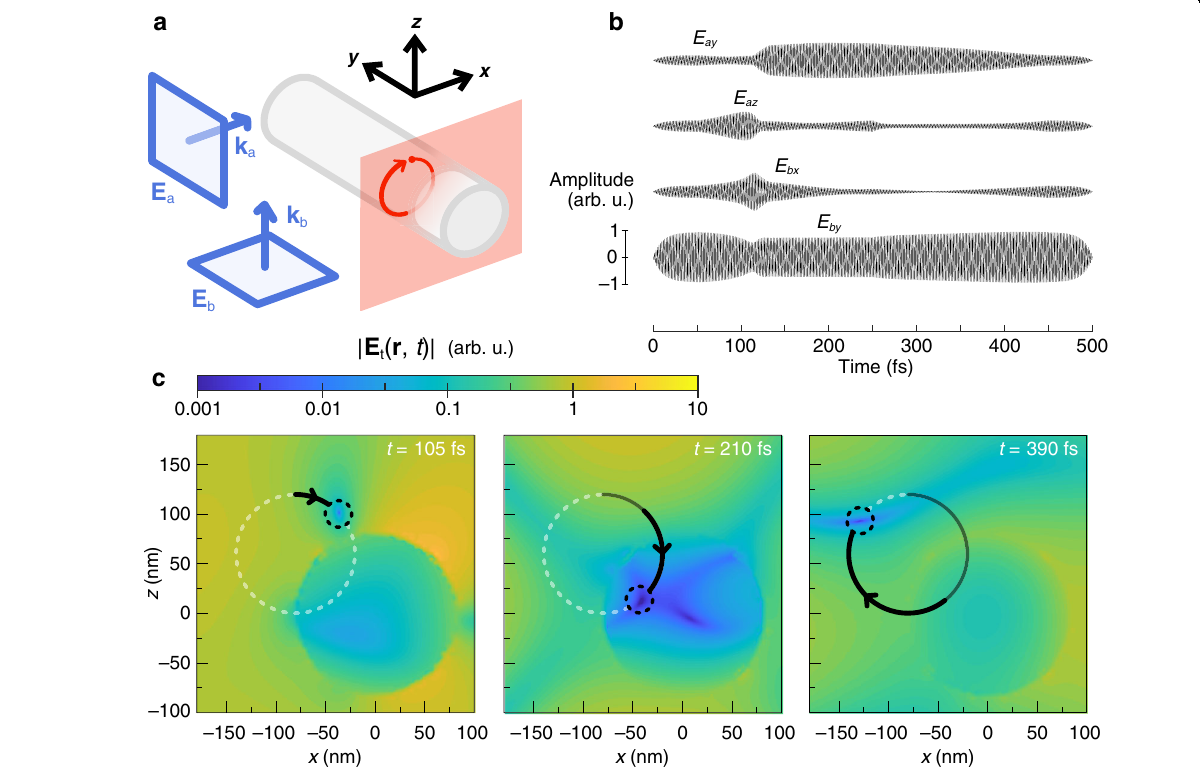
Fig. 6 Pulsed cold spot (a) Diagram of the silver nanorod and the circular path in the γ = − 200 nm plane, along which a cold spot is moved in the time domain by four modulated pulses. (b) Pulse shapes of the ^ y and ^ z components of E a (top two waves) and the ^ x and ^ y components of E b (bottom two waves) responsible for the movement of the cold spot. A reference amplitude scale to which each pulse is drawn is given next to the bottom pulse in arbitrary units. (c) Three snapshots of the time-dependent total electric fi eld magnitude, calculated in a time-domain simulation in CST Microwave Studio , on a section of the y ¼ (cid:2) 200 nm plane in arbitrary units. Each snapshot is taken at the indicated time and shows the cold spot at a different stage along the circular path. A complete video of the moving cold spot is given in the supplemental